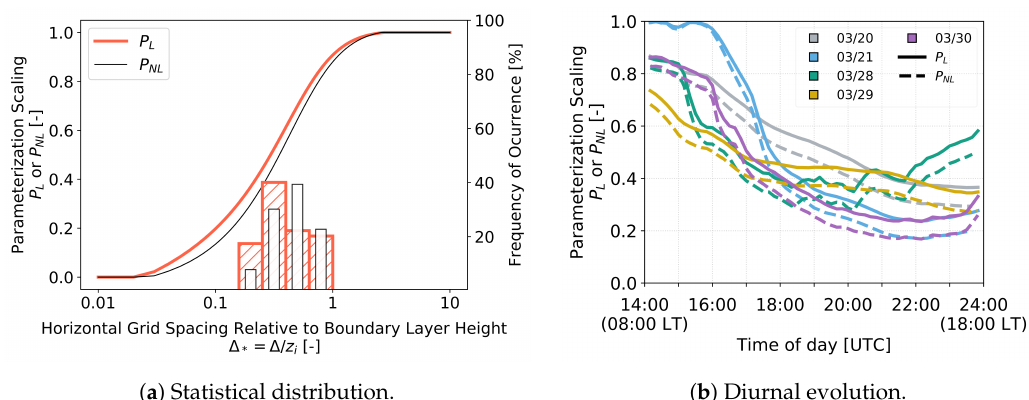
Figure 7. Values of the Shin-Hong parameterization grid-dependency functions P L and P NL for the five convective cycles simulated for this work. Left panel ( a ) shows the two functions (lines) and the frequency of occurrence of function values during the analyzed simulation times (bars). Right panel ( b ) shows the diurnal evolution of the two functions separated by day.